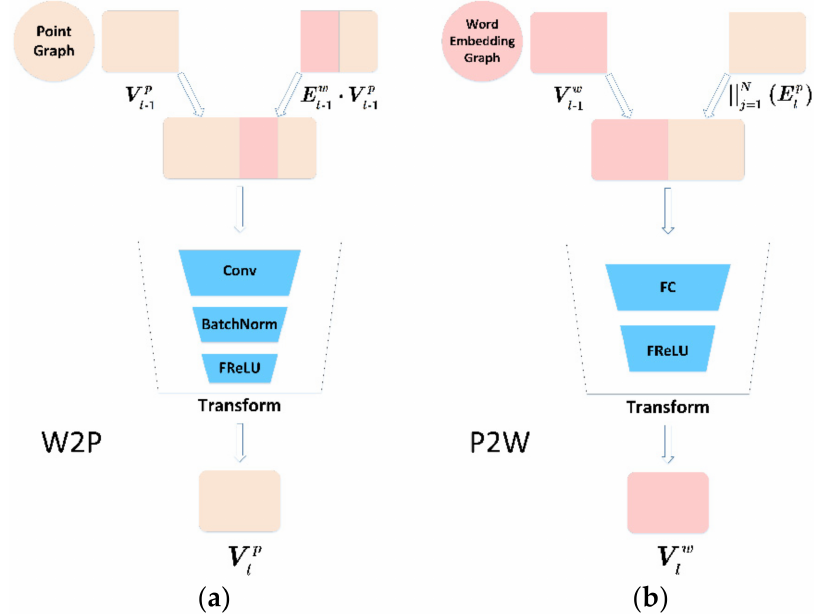
Figure 5. Details about W2P strategy and P2W strategy in the WPGN. ( a ) W2P; ( b )